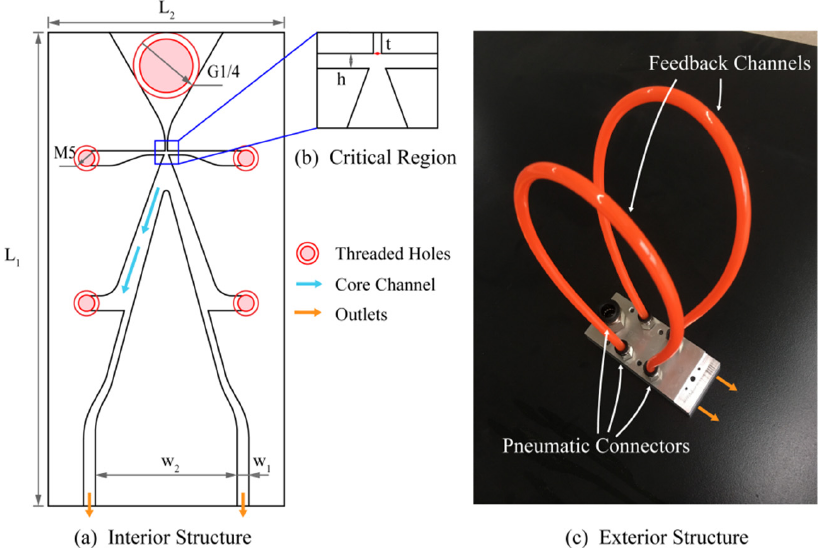
Figure 3. The interior and exterior structure of the fluidic oscillator: ( a ) interior structure; ( b ) critical region; and ( c ) exterior structure. Table 3. The key dimensions of the fluidic oscillator.